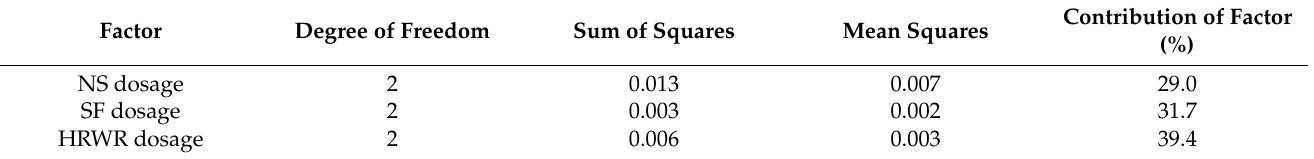
Table 12. Analyses of variance (ANOVA) for drying rate.